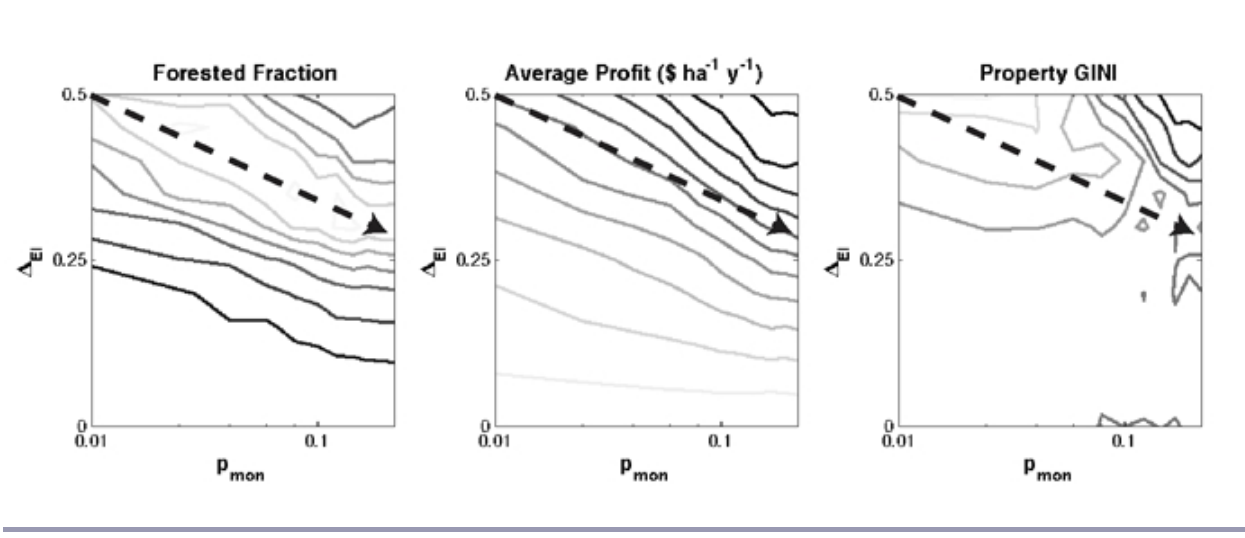
Fig. 7. Contour curves for the Low Network, Low Size Effect case shown in Figure 6; darker curves indicate lower values. A vector (dashed line) drawn along the ridge of nearly constant peak forested fraction corresponds closely with an isoprofit contour, but also with a nearly strictly decreasing property